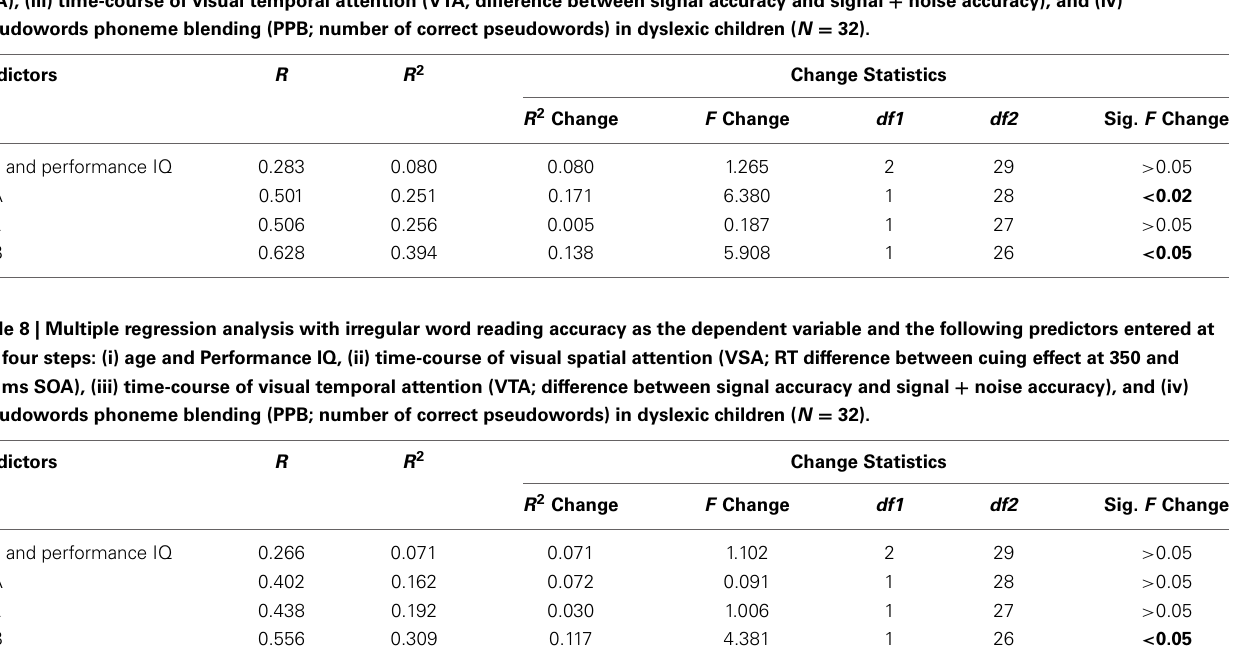
Table 7 | Multiple regression analysis with pseudoword reading accuracy as dependent variable and the following predictors entered at the four steps: (i) age and Performance IQ, (ii) time-course of visual spatial attention (VSA; RT difference between cuing effect at 350 and 100ms SOA), (iii) time-course of visual temporal attention (VTA; difference between signal accuracy and signal + noise accuracy), and (iv)